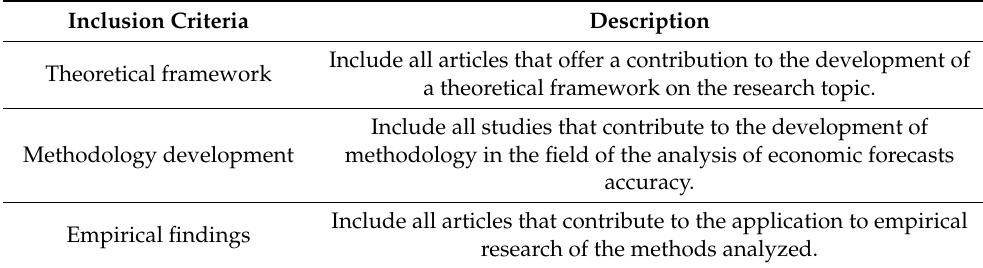
Table 2. Inclusion criteria for the systematic literature